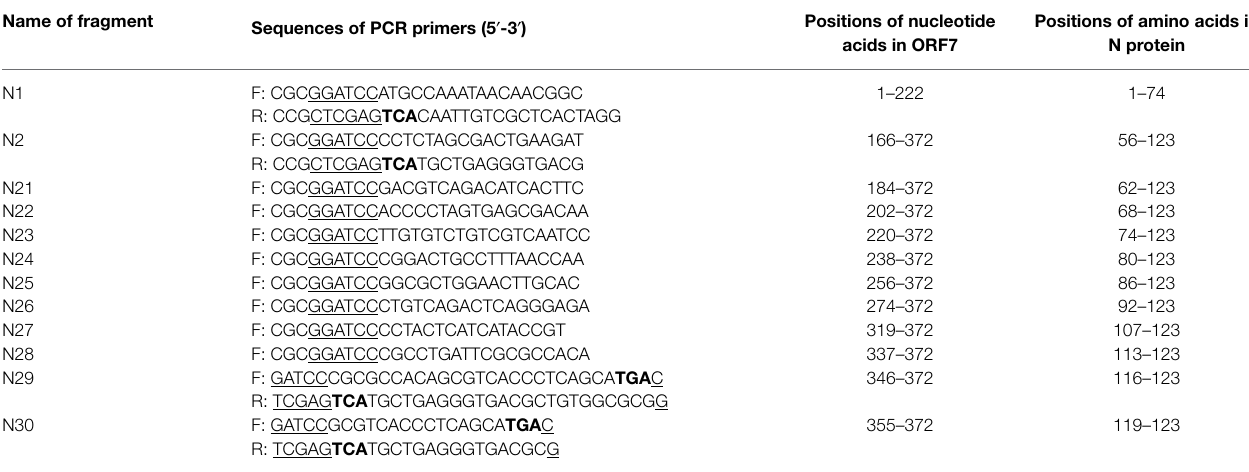
TABLE 1 | Primer sets for amplification of the SDHS53 ORF7 gene and its truncated